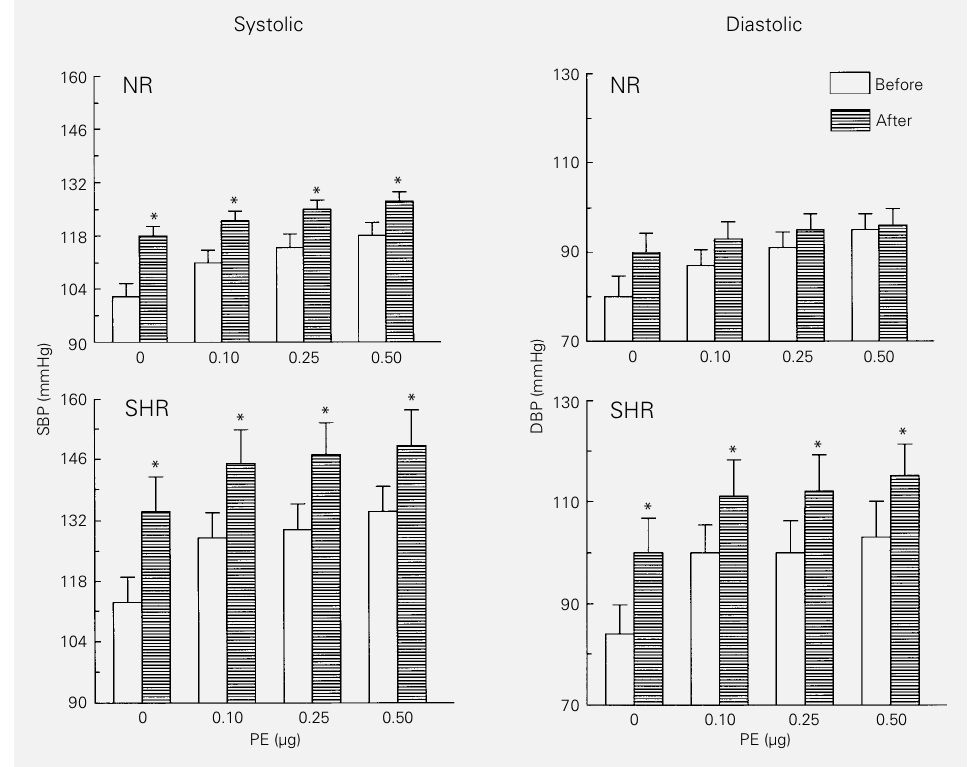
Figure 4 - Effects of increasing doses of phenylephrine (PE) on the systolic blood pressure (SBP) and diastolic blood pres- sure (DBP) of normotensive (NR) and hypertensive (SHR) rats be- fore and after 1-h treatment with 18 (cid:181)g/kg ouabain. Column height indicates the mean and the bar the SEM. *P<0.05 for comparison between before and after ouabain treatment